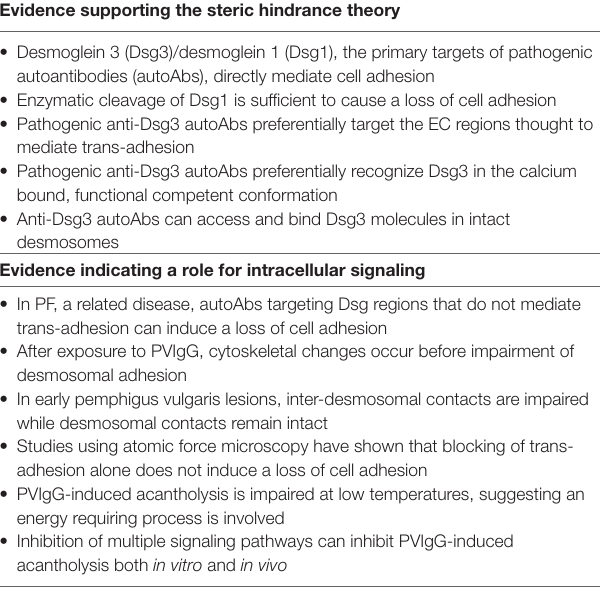
TABLe 1 | Evidence supporting steric hindrance vs. intracellular signaling. evidence supporting the steric hindrance